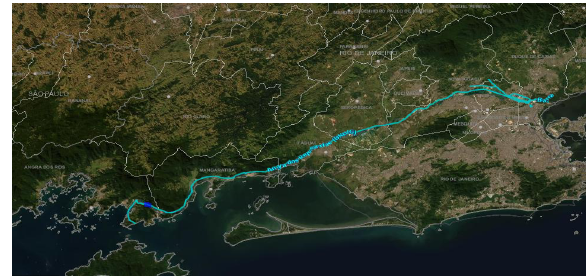
Figure 2. Location of pipeline ORBIG and surrounding